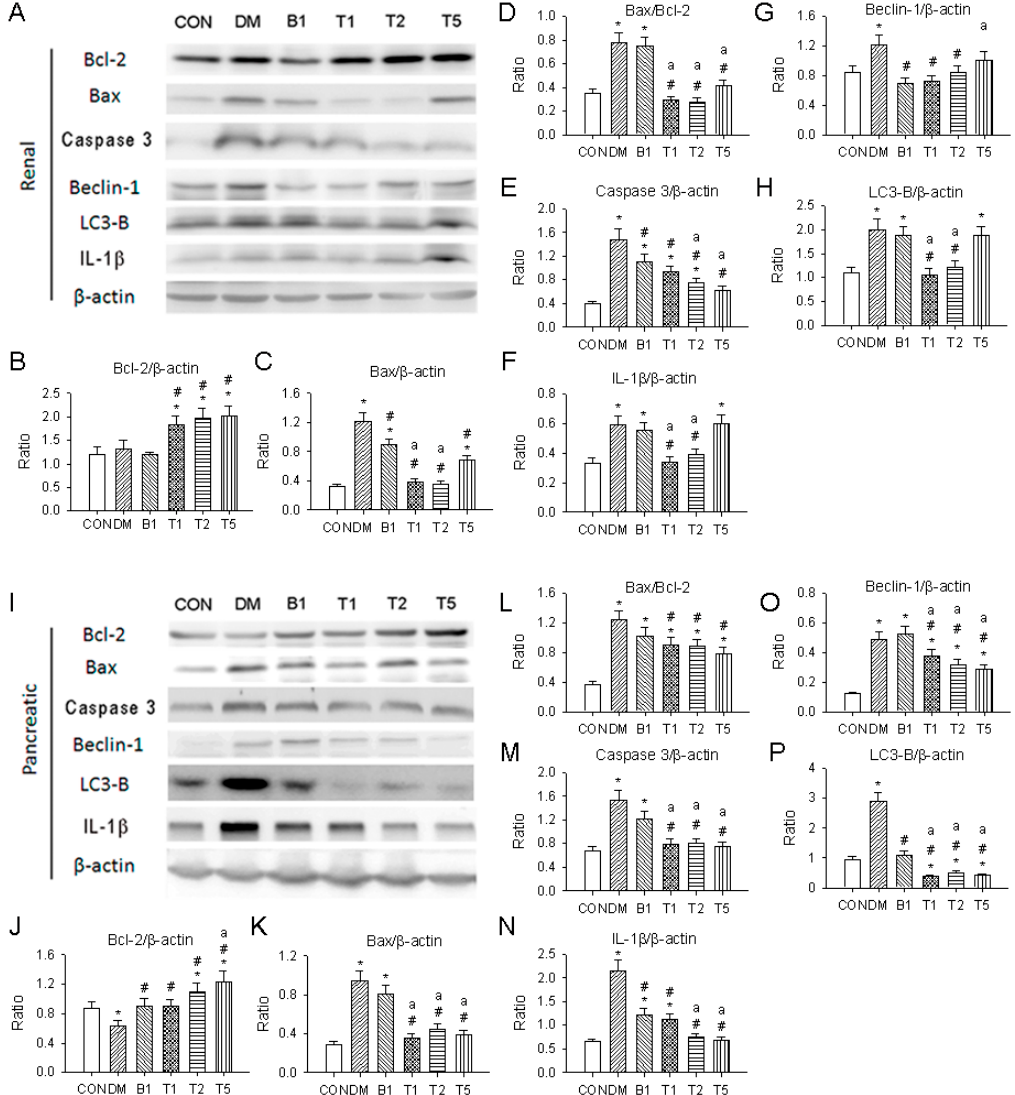
Figure 8. Effect of guava juice and trehalose on apoptosis-, autophagy- and pyroptosis-related proteins expression in the T2DM kidney and pancreas by western blot. Typical western blotting graphs of kidney ( A ) and pancreas ( I ) are shown; The statistical data of each protein expression and ratio are shown in the kdieny ( B – H ) and pancreas ( J – P ). Data are expressed as mean ± SEM. n = 3–5